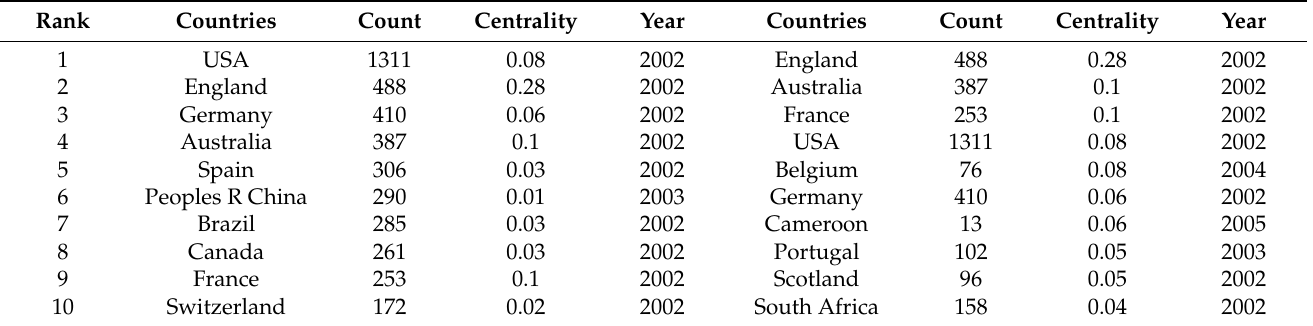
Table 1. The 20 countries or regions with the highest total number and centrality of research papers published in the